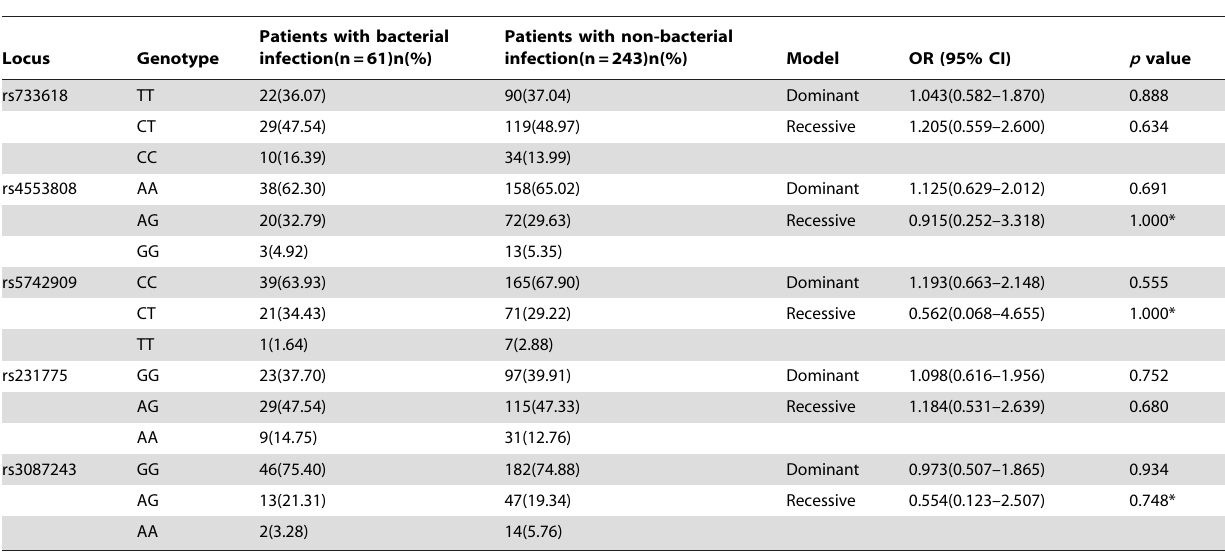
Table 2. The genotype distribution of the CTLA4 polymorphisms in patients with bacterial infection and non-bacterial infection.